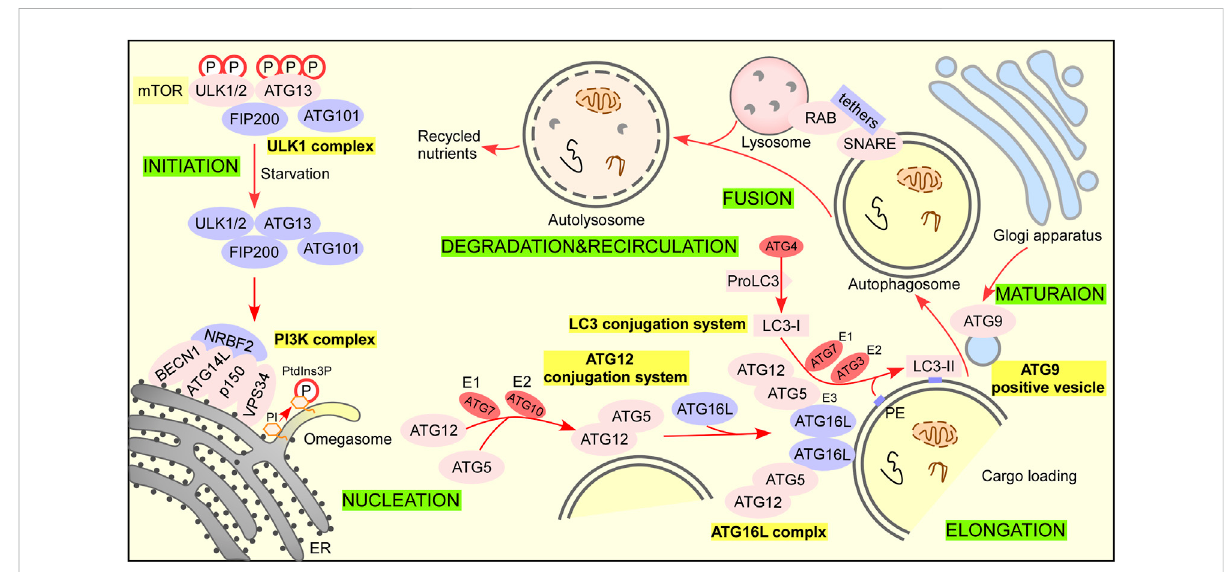
FIGURE 2 Theautophagypathway.Thereare6stepsintheautophagypathway.Step1Initiation:activationofULK1complexandmultipleATGproteinsare engagedandlocalizedtoPAS.Undernutrient-richconditions,mTORC1phosphorylatesATG13andULK1/2andblockstheinteractionofATG13with ULK1/2, FIP200, and ATG101 to inactivate them (Hosokawa et al., 2009a; Hosokawa et al., 2009b; Park et al., 2016). When treated with rapamycin or understarvationconditions,mTORC1dissociatesfromthecomplexandpartiallydephosphorylatesthesesitesresultinginthecomplexanchors toapre-autophagosomalstructure(PAS)thatrecruitsautophagy-related(ATG)proteinsontoittoinitialautophagy(Chan,2009).Steps2Nucleation: ATG12 conjugation system and LC3 conjugation system are recruited to form phagophore. The ubiquitin-like protein ATG12 activated by the E1 enzyme ATG7 and E2 conjugating enzyme ATG 10 is irreversibly conjugated to ATG5 (Geng and Klionsky, 2008; Nakatogawa, 2013).